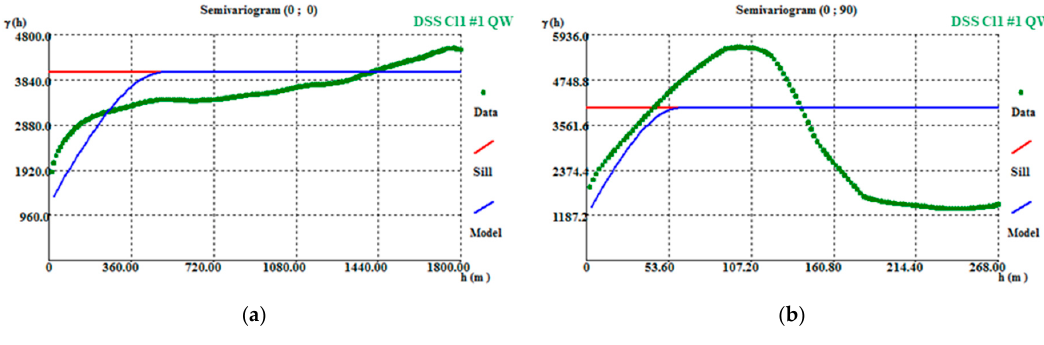
Figure A11. Stope wolframite quantity (kg/m 3 ) directional variograms: ( a ) horizontal omnidirectional variogram and ( b ) vertical variogram. On a 10 m × 10 m × 2 m grid.